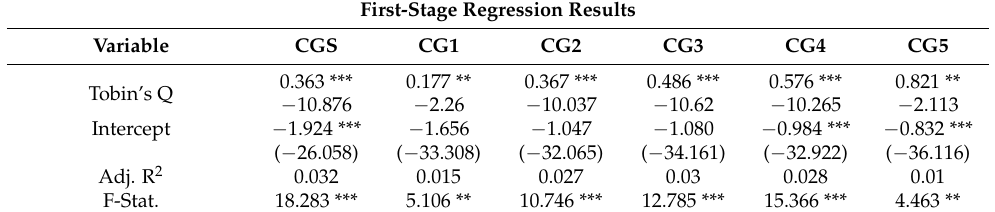
Table 9. Regression results of the 2SLS